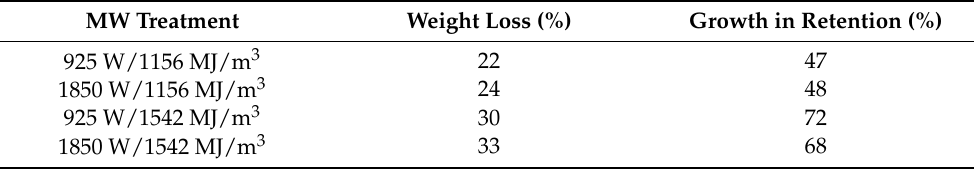
Table 12. Weight loss and preservative agent retention found by